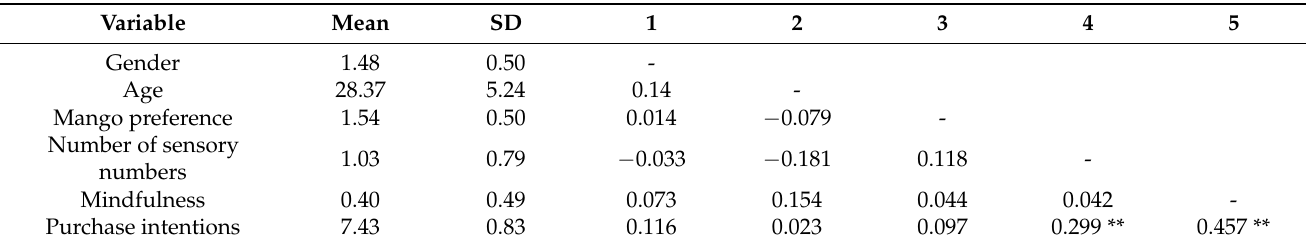
Table 1. Descriptive statistics and correlations of main variables in Study